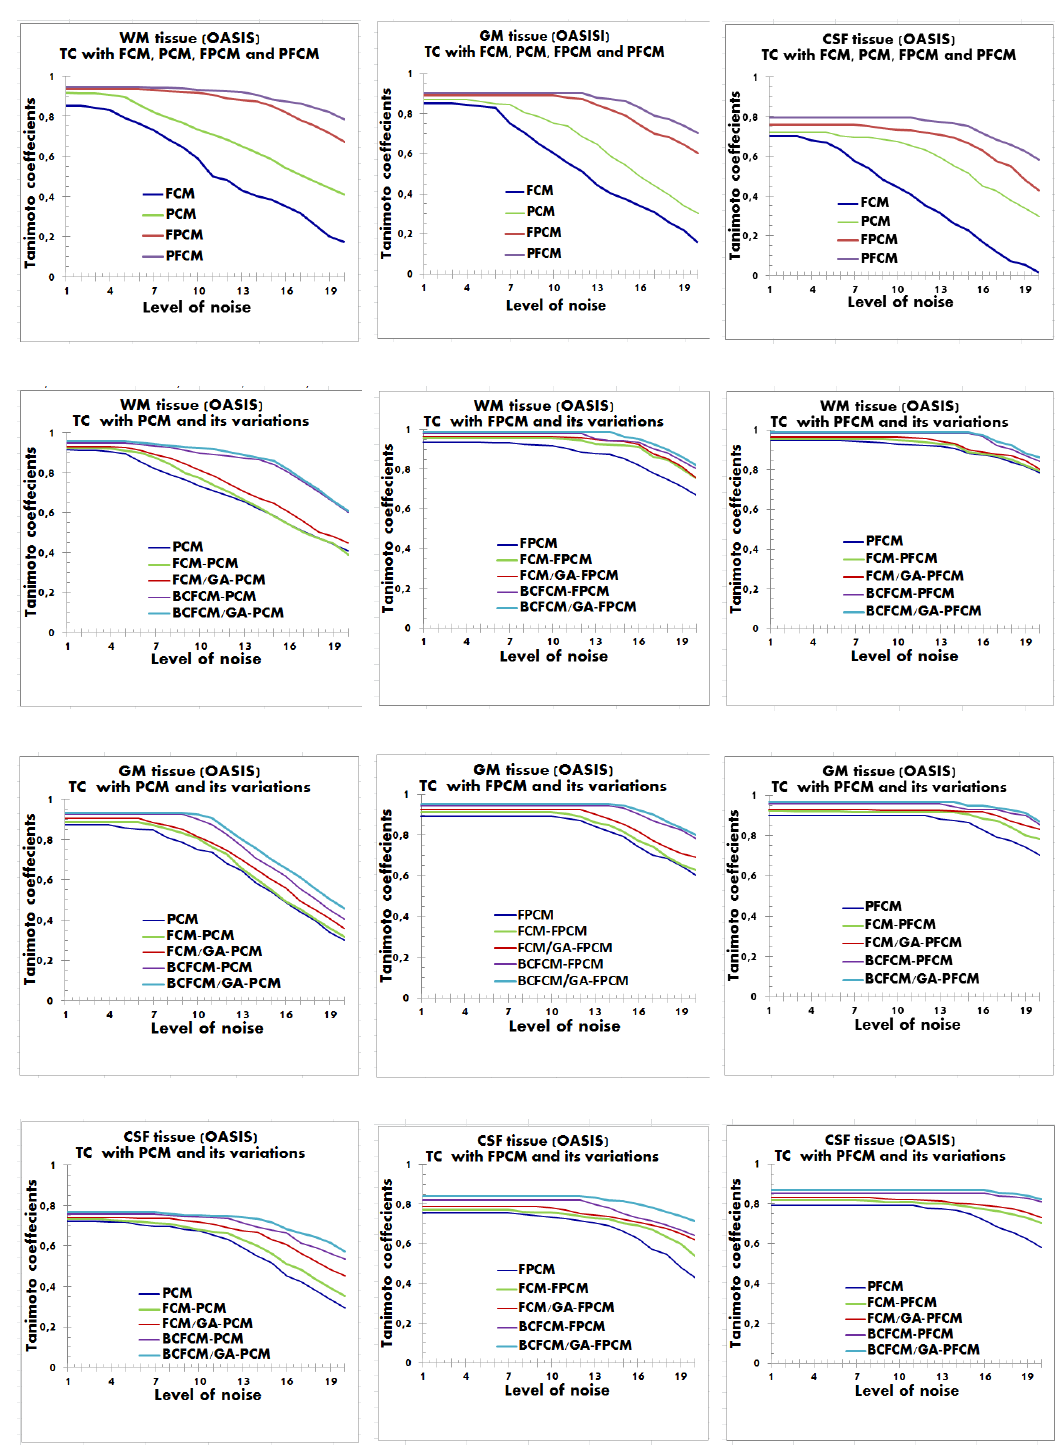
Figure 9. Curve of Tanimoto coefficients clustering index for WM, GM and CSF tissues with additive noise between 1% and 20%. Application with the hybrid approach BCFCM / GA / PFCM for an OASIS image. The results of modeling approaches from (1) to (15) are reported viz., (1) FCM, (2) PCM, (3) FCM / PCM, (4) FCM / GA / PCM, (5) BCFCM / PCM, (6) BCFCM / GA / PCM, (7) FPCM, (8) FCM / FPCM, (9) FCM / GA / FPCM, (10) BCFCM / FPCM, (11) BCFCM / GA / FPCM, (12) PFCM, (13) FCM / PFCM, (14) FCM / GA / PFCM, (15) BCFCM / PFCM. Legend : BCFCM: Bias corrected FCM; FCM: Fuzzy